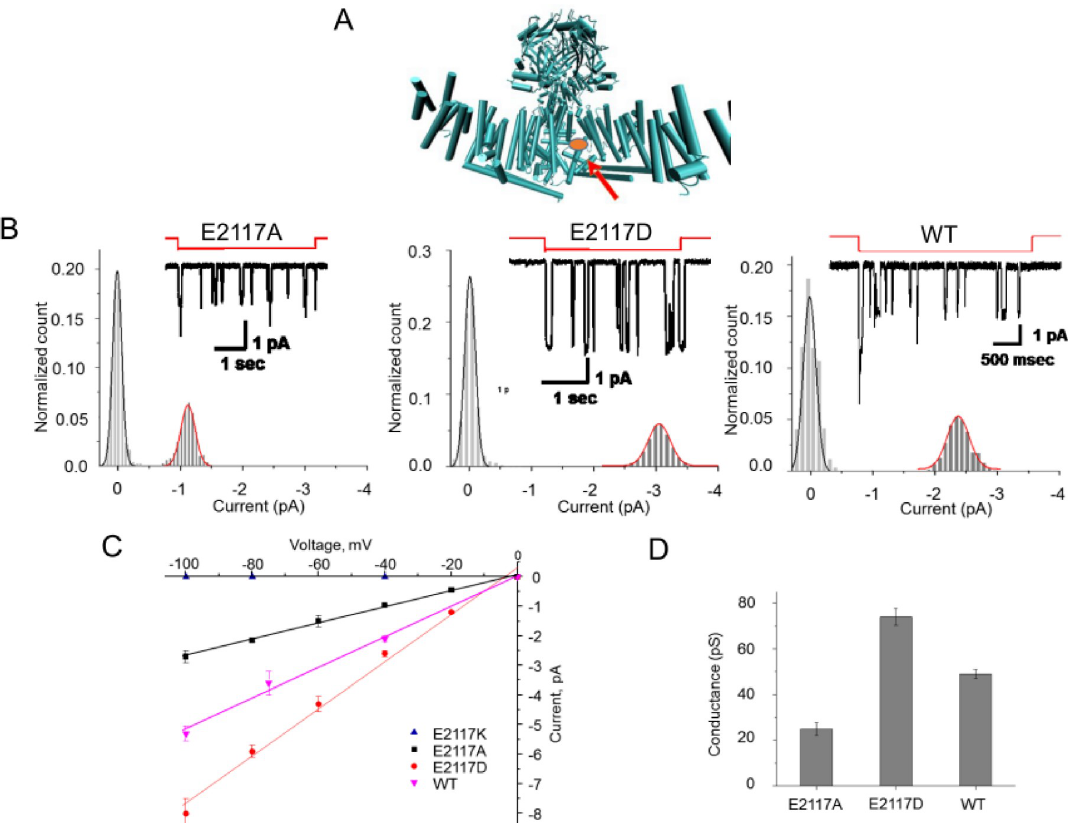
Fig 1. Mutations at position 2117 of hP1 altered channel conductance. (A) indicates the location of the 2117D (red ball and arrow) using the mouse CryoEM structure of mouse PIEZO1. (B) shows single channel currents from a cell-attached patch containing E2117A (Left) , E2117D (Middle) and the wild-type (Right) . The amplitude histograms of unitary currents are included. All recordings done in a high K + bath to clamp the membrane potential to near zero. The pipette solution was 160 mM KCl without divalent ions. The suction stimulus of -20 mmHg is in red above the current trace, and the duration was 3–4 seconds at -50 mV. (C) (Left) shows the current-voltage relationship at negative membrane potentials. The slopes are 25 pS (R 2 > 0.99) for E2117A, 73 pS (R 2 > 0.99) for E2117D, and 49 pS (R 2 > 0.99) for the wild-type. (D) the mean current, averaged over multiple patches at -100mV is summarized in the bar graph (Right) . In all cases, the currents reversed near 0 mV. These data are an aggregate response from > 15